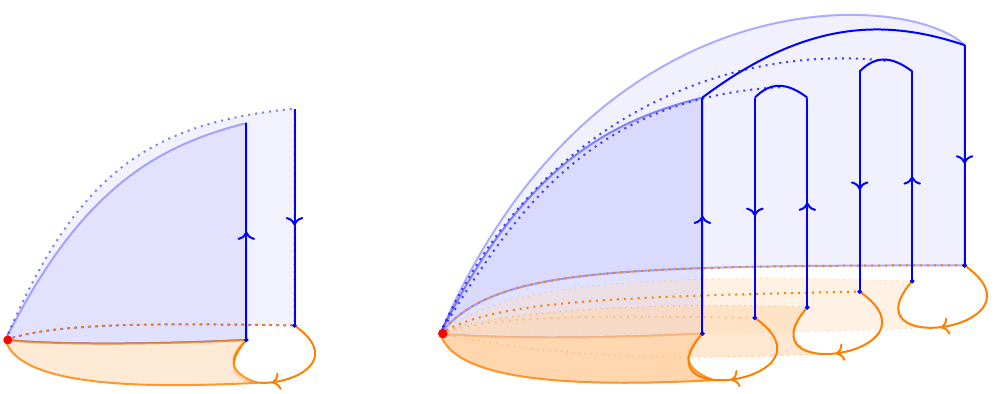
Figure 10. Gravity dual of the field theory computation illustrated in figure 9. The bulk thermal density matrix ρ ( t ) is obtained by slicing open the Euclidean black hole spacetime, with suitable real- time evolution ending on the cuts thus created. The cuts are pinned at the tip of the Euclidean cigar, which corresponds to the bifurcation surface of the black hole. Lorentzian sections are the time- evolution of the initial state, which geometrically gives rise to the domain of outer communication This is a particularly convenient choice. One can also include part of the real-time black hole interior. This does not matter as the unitary evolution cancels between the bra and ket pieces as described. For our choice we have two such copies one for the ket and another for the bra as indicated on the left panel. On the right we illustrate the ansatz for the computation of Tr (cid:0) ρ ( t ) 3 (cid:1) ; we have copies of the density matrix constructed gravitationally sewn together capturing the kinematic data. Dynamics dictated by the gravitational equations of motion, will ensure the absence of any singularity at the splitting surface g as discussed in the